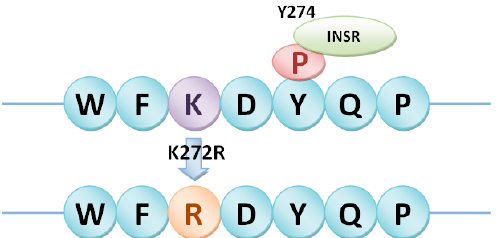
Figure 3. Type II ( − ) phosSNP, K272R, in heterotrimeric G α subunit (LOC_Os05g26890), which removed the adjacent protein phosphorylation site of Y274. Green oval: Specific kinase type of the phosphorylation site; The same as below. INSR: Insulin receptor tyrosine kinase.